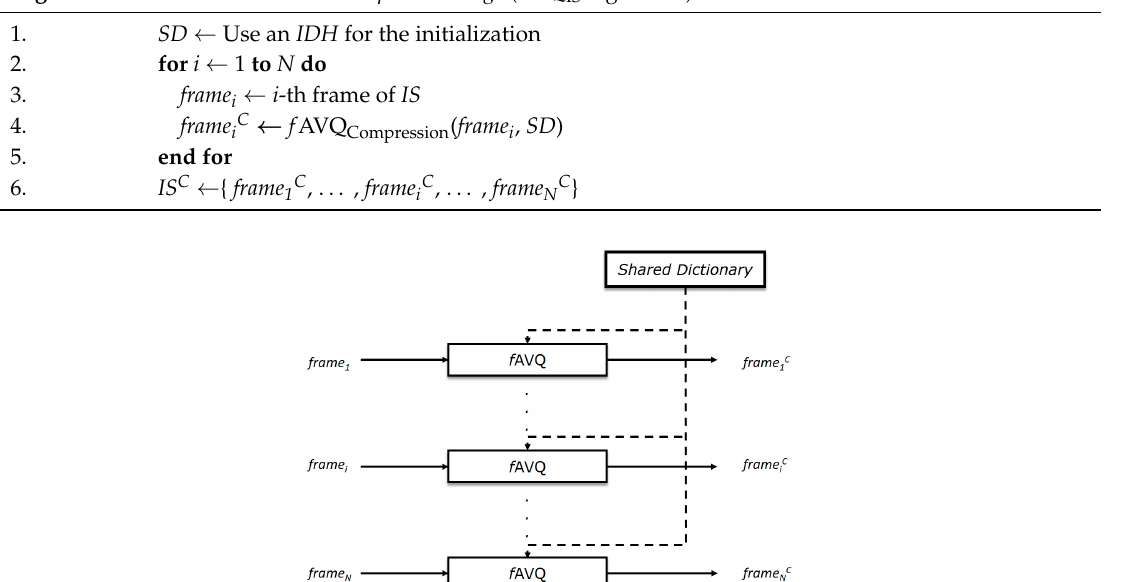
Algorithm 3. Pseudo-code of the compression stage (AVQ IS algorithm).